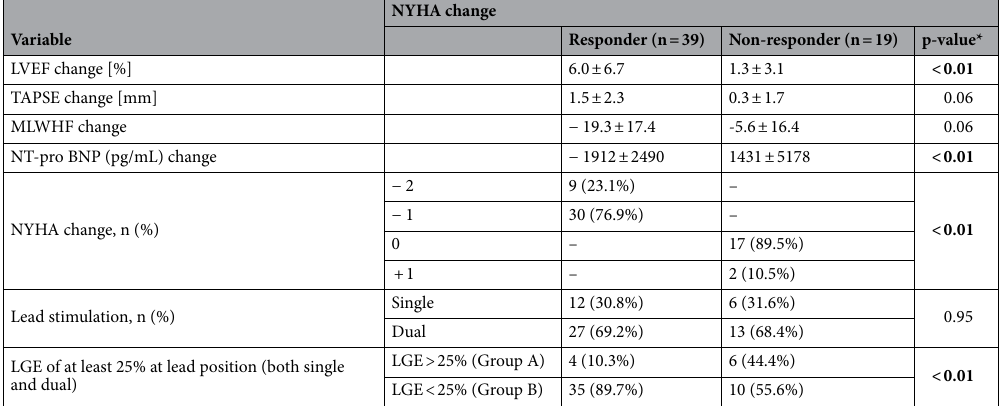
Table 2. Responder vs. non-responder based on NYHA change. LGE late gadolinium enhancement, NYHA New York Heart Association, FU follow-up. Values in bold are statistically significant. *Pearson Chi-square